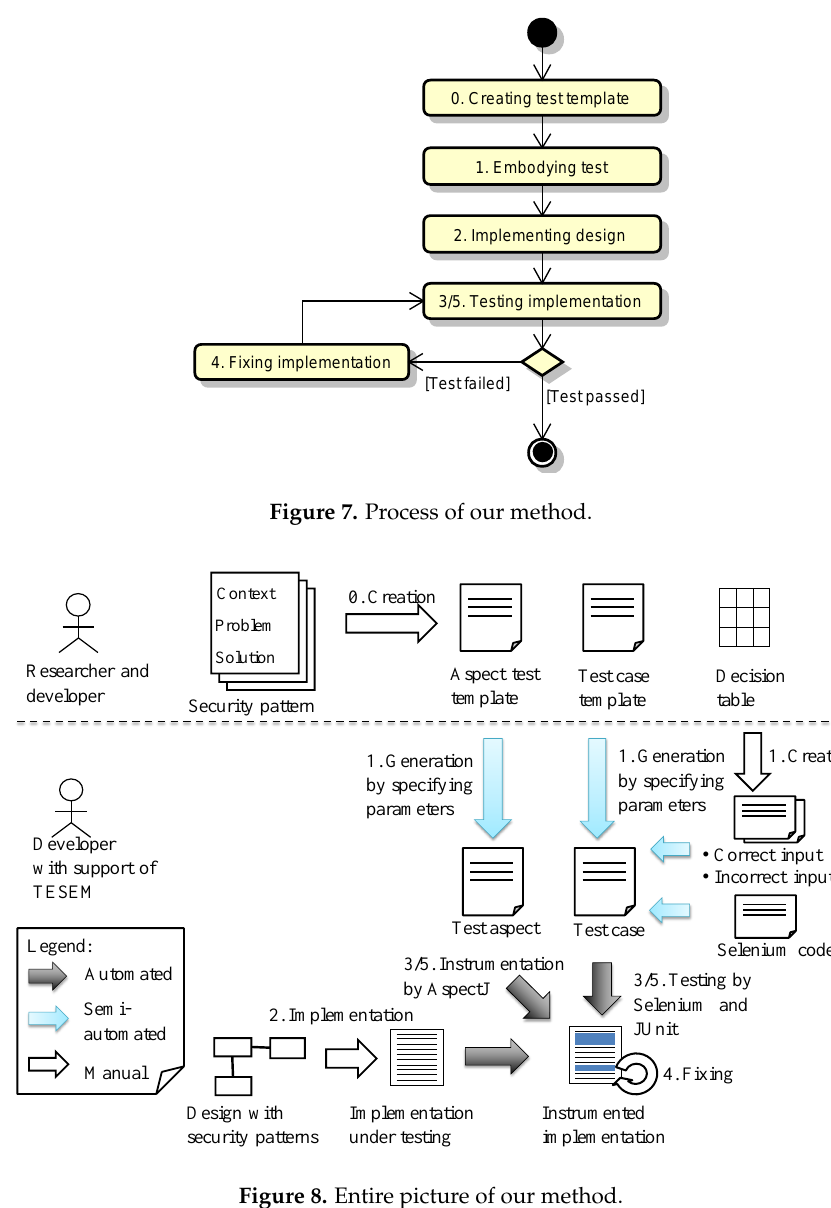
Figure 8. Entire picture of our method.